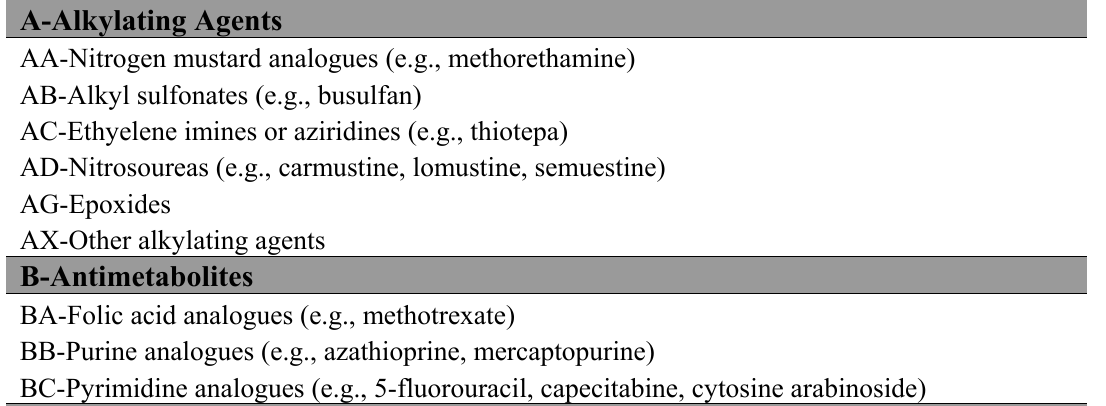
Table 2. Classification of antitumoral drugs according to their Anatomical Therapeutic Chemical (ATC)